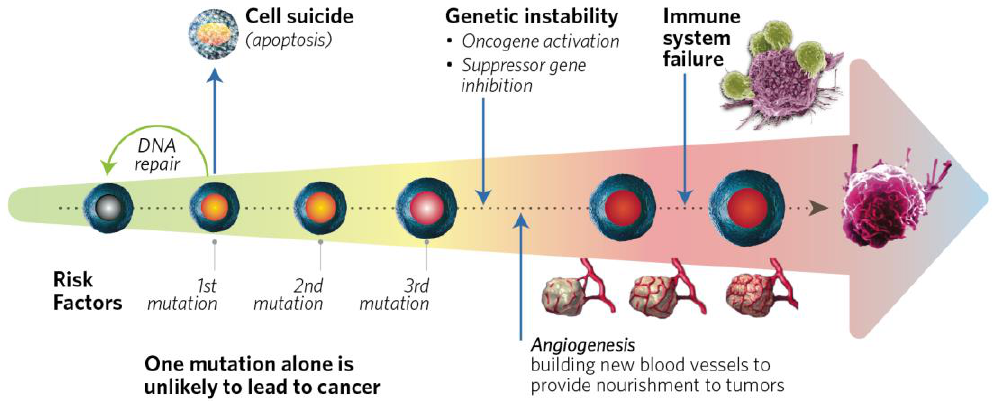
Figure 3. Cancer results from mutations involving genetic factors and epigenetic modifications affecting gene expression, a multitude of risk factors, lifestyle, microbiota resulting in vast biochemical changes that affect cell multiplication, survival, apoptosis, and evading surveillance by the immune system, culminating in cancer and